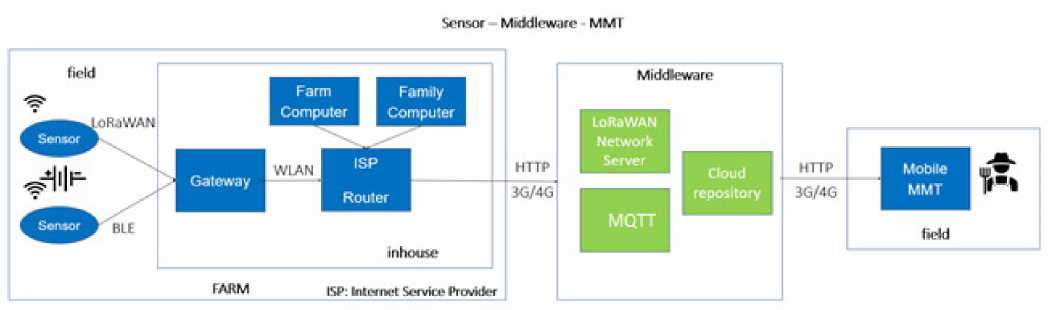
Figure 4. Sub-SuC for